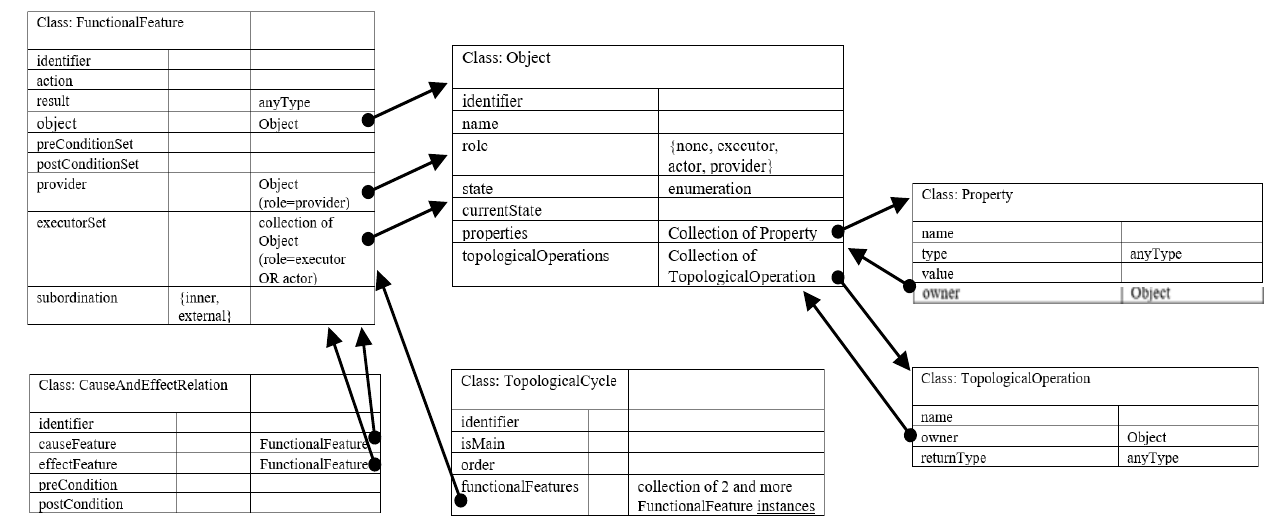
Fig. 2. The schema of the frame system.